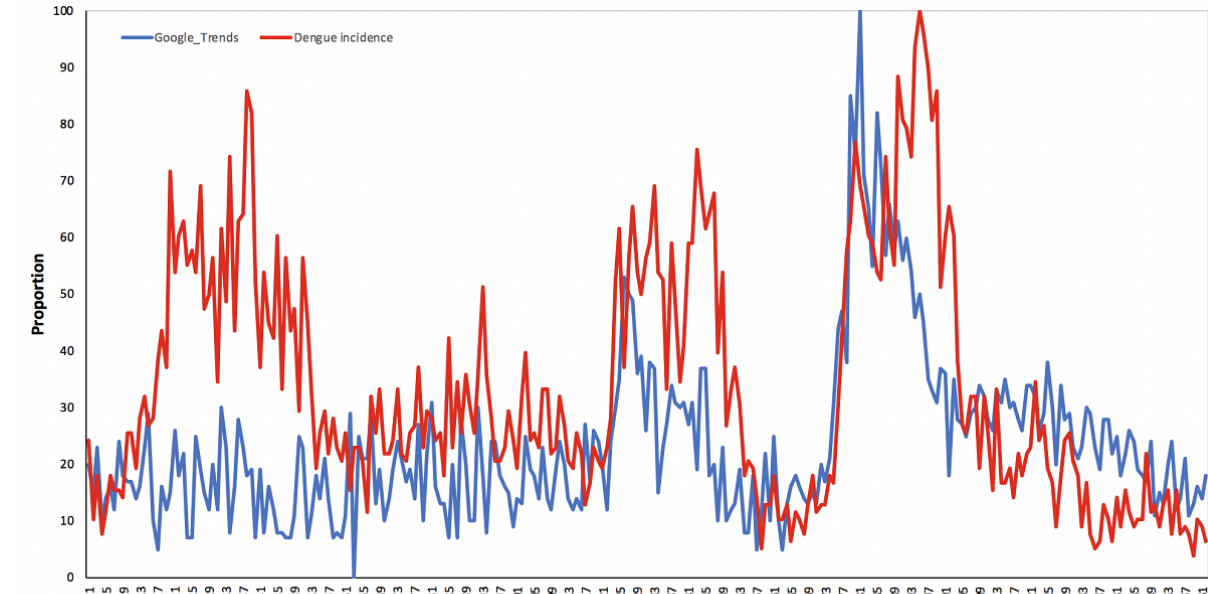
Figure 1. Dengue data plot from Google Trends and reported cases in